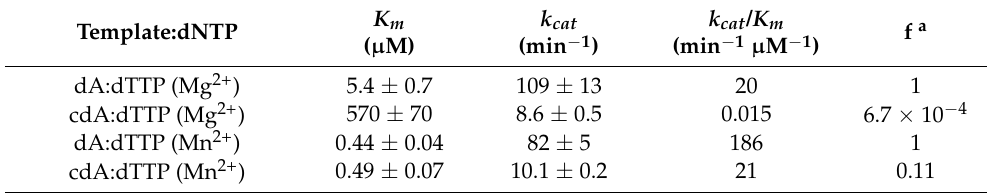
Table 2. Kinetic parameters for nucleotide incorporation opposite cdA and dA by pol η [53].